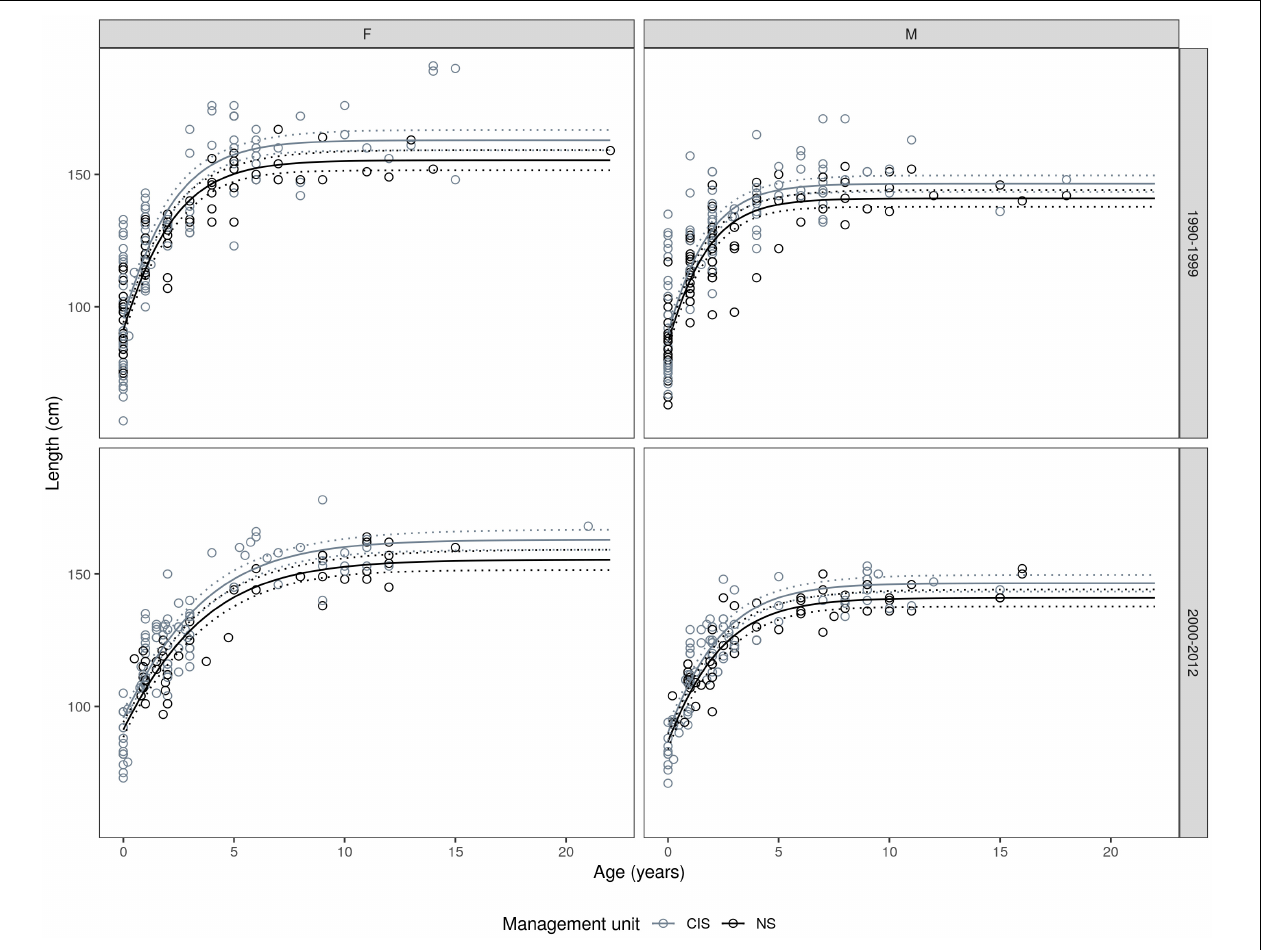
FIGURE 4 | Gompertz growth models fitted to the length-at-age data; fitted by sex, time period, and management unit (see Table 2 for n values and growth parameters). Stippled lines represent the 95% confidence intervals for the growth